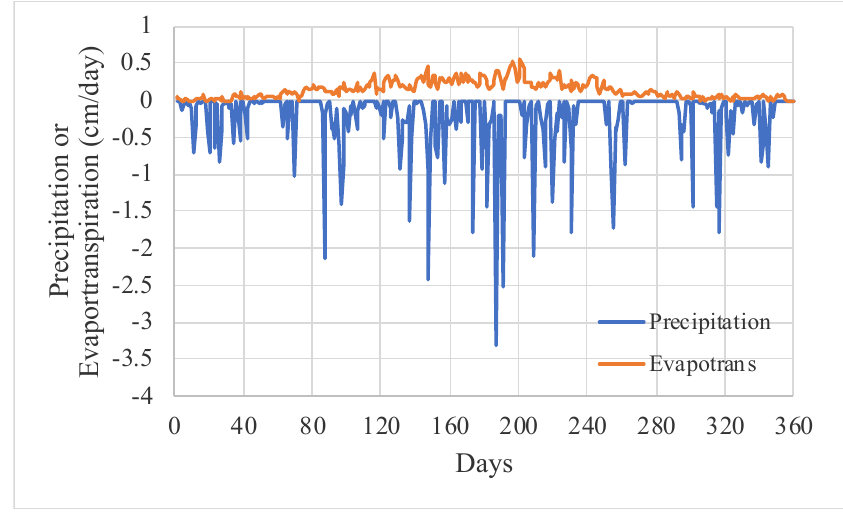
Figure 4. Time-variable atmospheric data. Negative values indicate input to simulation